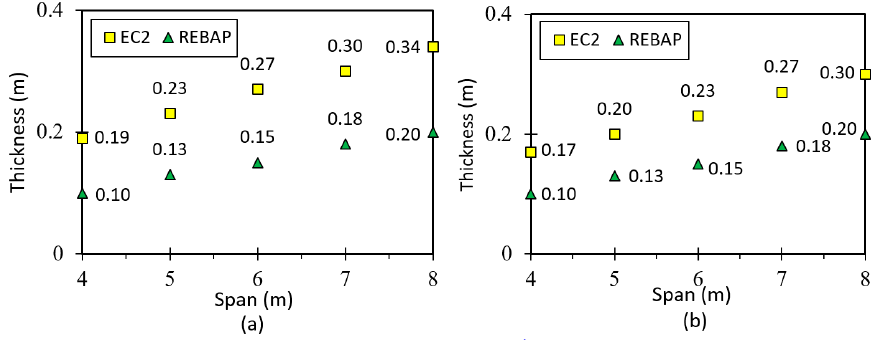
Figure 2. ( a ) Minimum thickness of the fixed-ended supported slab and ( b ) of the fixed-ended slab.